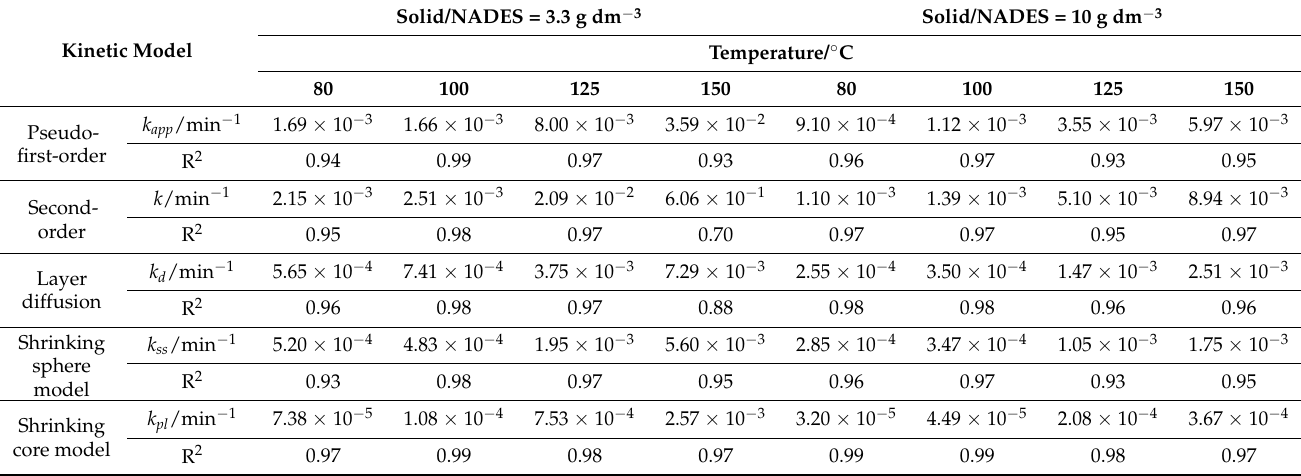
Table 3. Kinetic Parameters and fitting for Mn oxide leaching as a function of temperature, solid/NADES = 3.3 and 10 g dm − 3